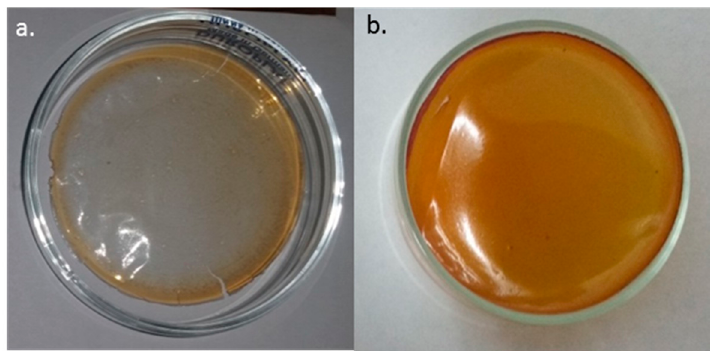
Figure 2. PAAG-12 control film ( a ) and film with 5% α -tocopherol ( b ). The thickness of the PAAG-12 film with α -tocopherol was 0.142 mm.